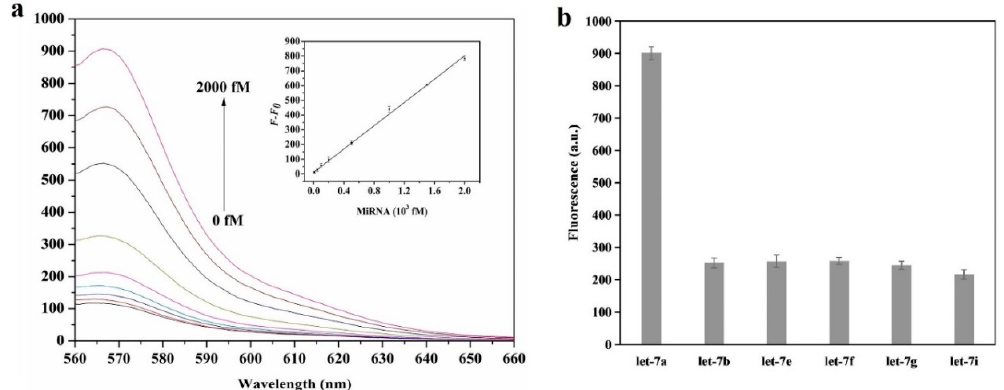
Figure 6. ( a ) Fluorescence spectra of the HCR/GO biosensor in the presence of different concentrations of let-7a (from bottom to top 0, 10 fM, 50 fM, 100 fM, 200 fM, 1 pM, 1.5 pM, 2 pM). Inset: linear relationship between the fluorescence intensity change (F–F 0 ) and let-7a concentration. ( b )